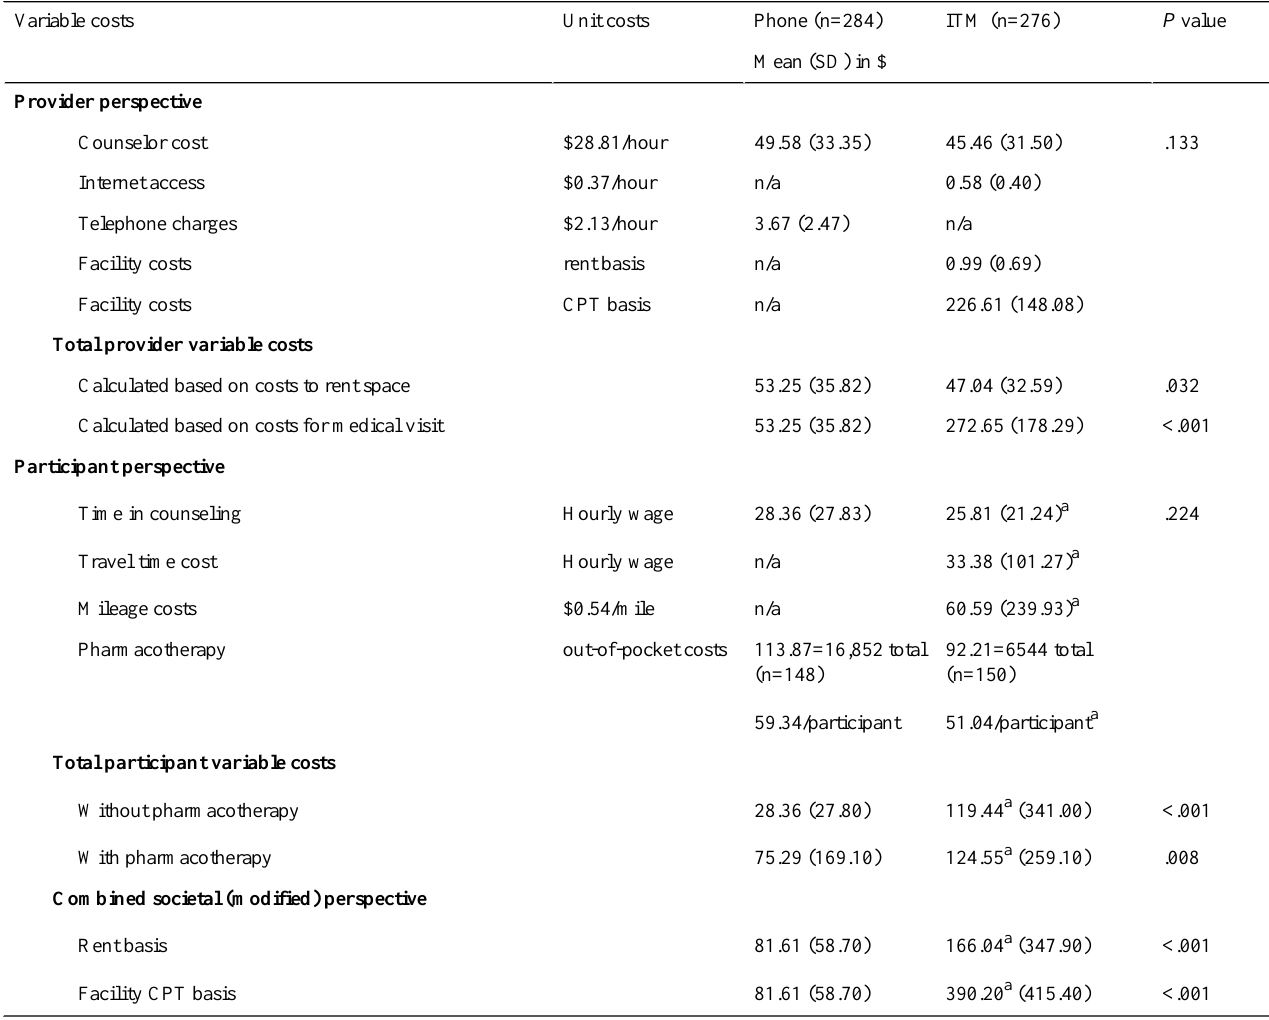
Table 3. Input valuations and results for variable cost components by intervention arm (US